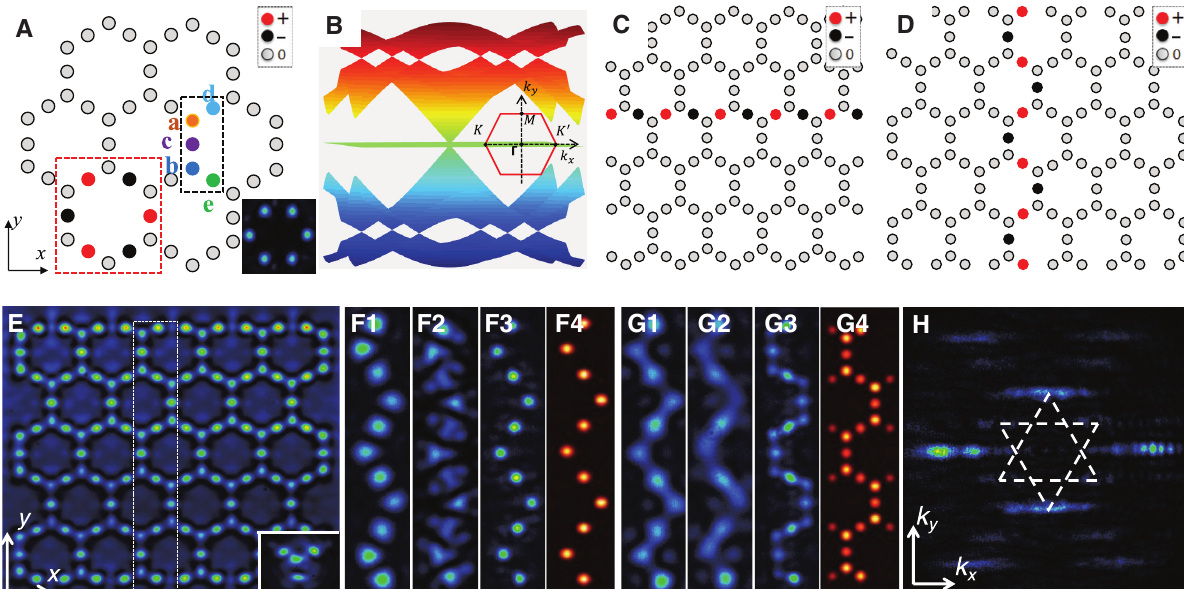
Figure 7: Demonstration of unconventional line states in a finite photonic sHCL with bearded edges [85]. (A) Schematic of sHCL structure consisting of five sites (a–e) shown in dark-dashed square, with a flat-band mode (the CLS) shown in red- dashed square. Sites with zero amplitudes are denoted by gray color, and those with nonzero amplitudes of opposite phase are denoted by red and black colors. (B) Calculated band structure based on the tight-binding model. (C, D) sHCL with two different cutting boundaries that support (C) a “straight” line along x direction and (D) a “zigzag” line along y -direction. Red and black colors represent opposite phase. (E) The cw-laser-written sHCL. The white dashed line marks the position of the probe beam. (F) From left to right: (F1) the input of the out-of- phase probe beam, (F2) output without the lattice, (F3) output through the lattice, and (F4) simulated version of (F3). (G) Setup is as in (F) but with an in-phase probe. (H) Momentum space spectrum of (F3), where the dashed lines outline the first and second